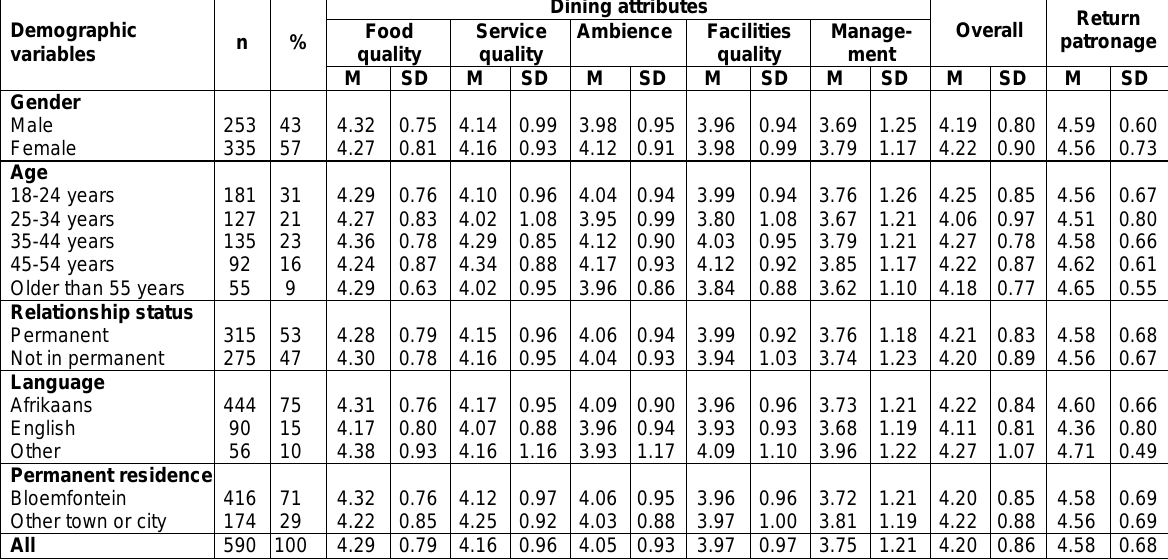
Table 1: Demographic information and overall means and standard